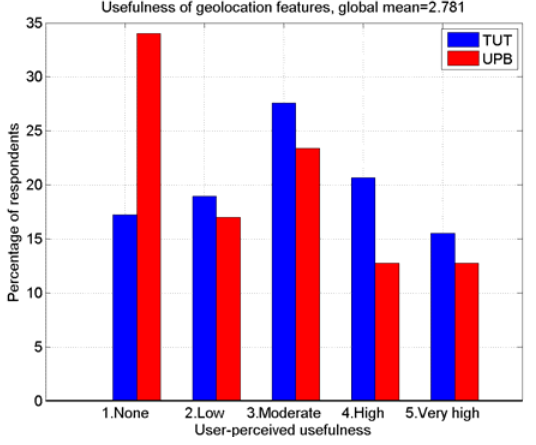
Figure 15. User-perceived usefulness of geolocation applications such as Facebook